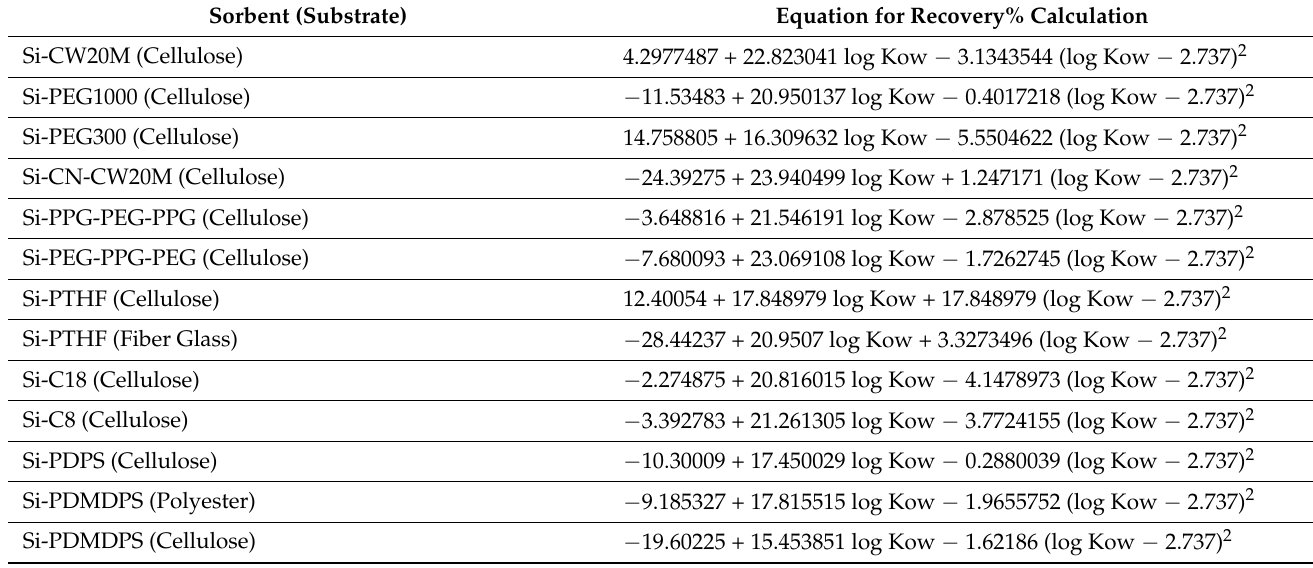
Table 2. Table 2. Absolute recovery calculator for selected FPSE